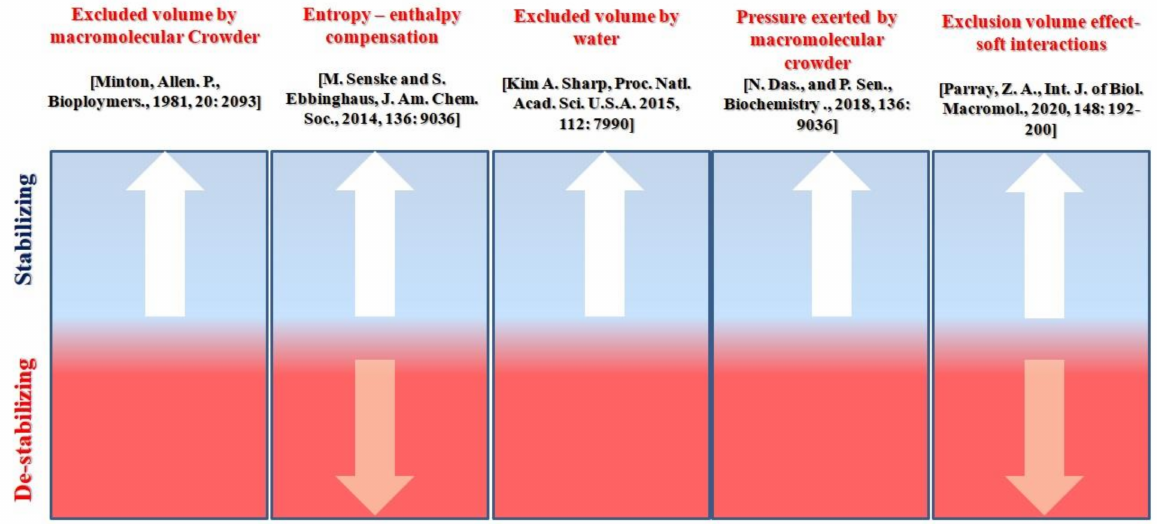
Figure 7. The schematic understanding of protein stability by crowder molecules through various modulations from excluded volume effect alone to excluded volume-soft interactions in a chronological